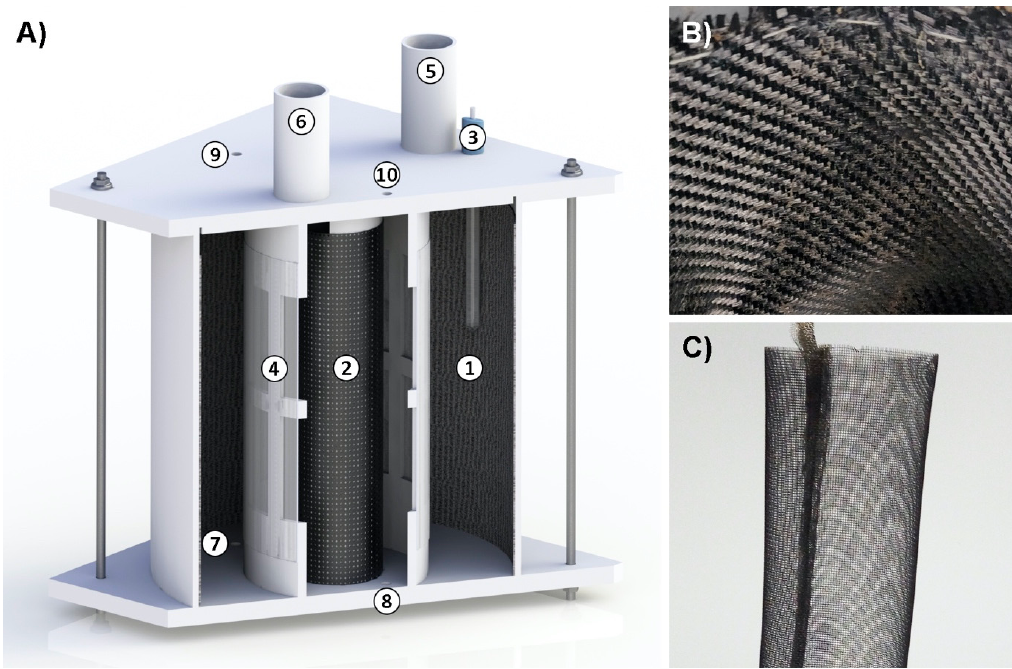
Figure 1. Reactor scheme ( A ): 1—biocathode; 2—anode; 3—reference electrode; 4—cation exchange membrane; 5, 6—sampling ports of cathode and anode chambers; 7, 8—cathodic and anodic chambers